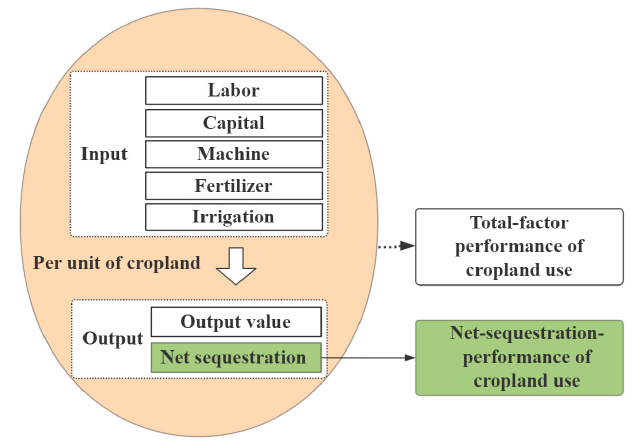
Figure 3. Theoretical framework for analyzing the NCSPC.